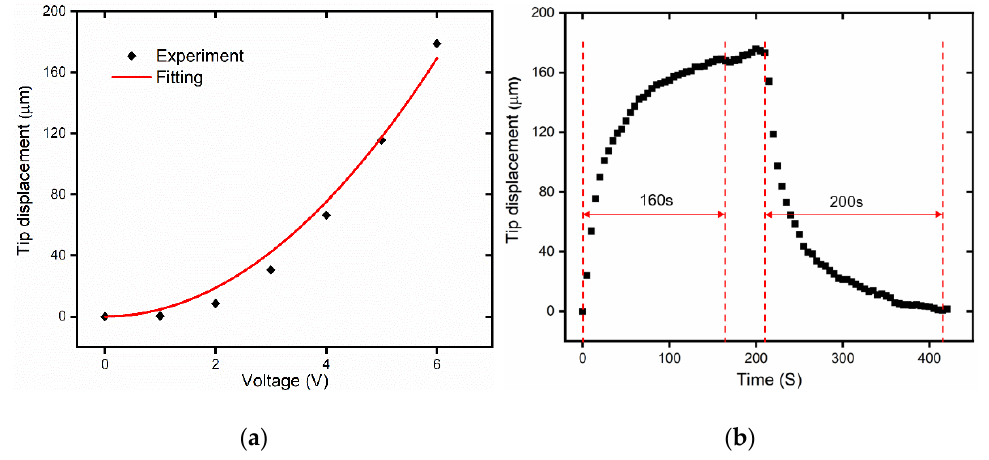
Figure 10. The static and dynamic testing of the microgripper V-shaped actuator. ( a ) The static displacements vs. voltages; ( b ) The dynamic response of the V-shaped actuator under a voltage of 6V.